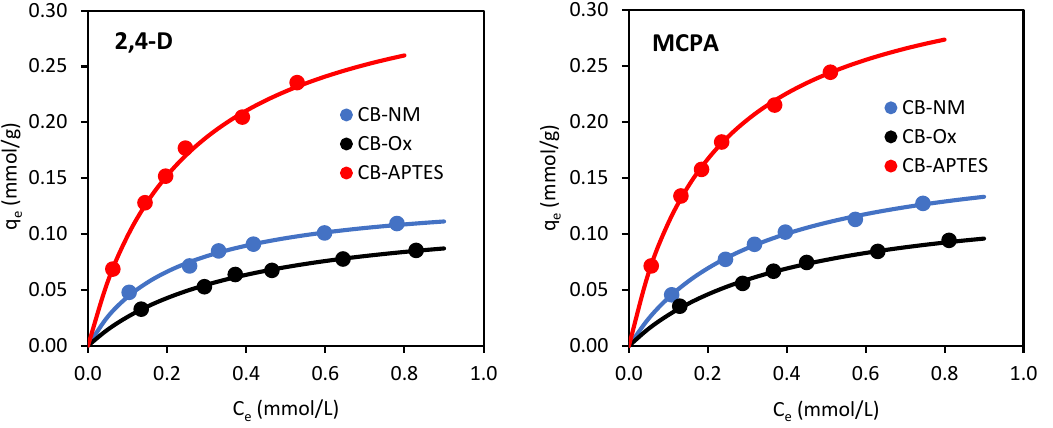
Figure 9. Adsorption isotherms of 2,4-D and MCPA from aqueous solutions on carbon black samples (line: fitting of Langmuir isotherm).